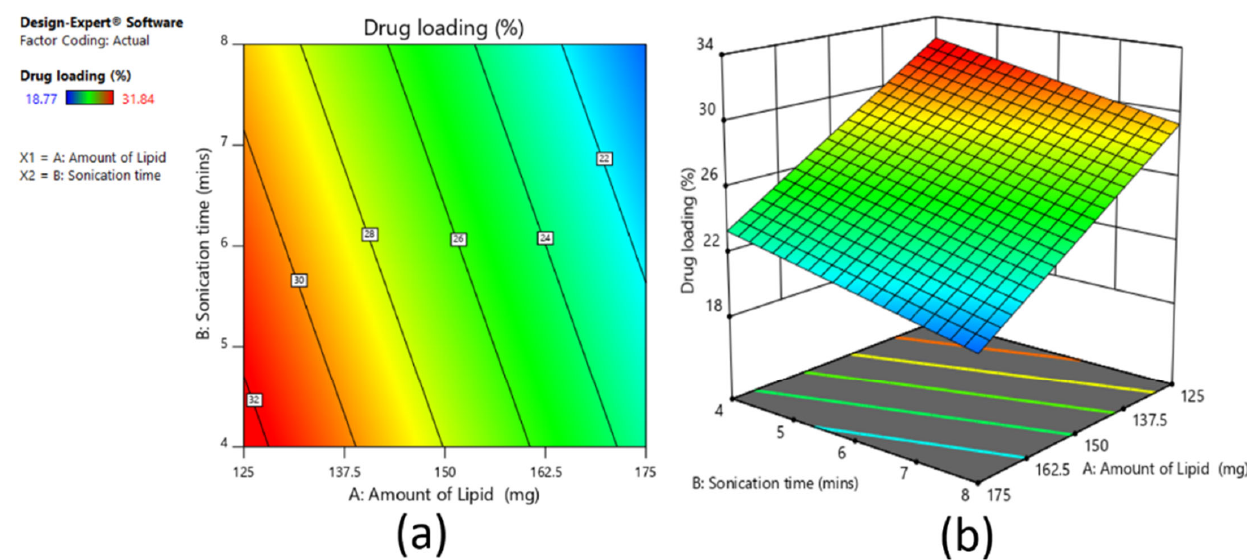
Figure 7. Contour plot ( a ) and 3D surface plot ( b ) representing the effect on percent drug loading for full factorial design batches.